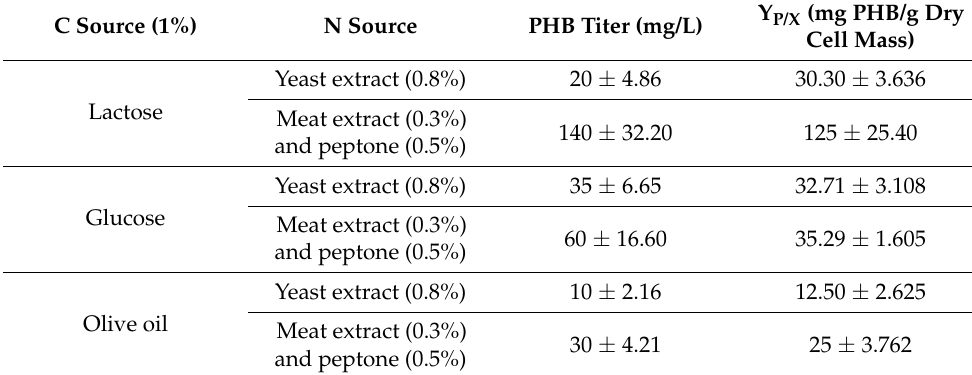
Table 1. Comparison of olive oil, glucose, and lactose by PHB titer (mg/L) and Y P/X (mg PHB/g dry cell mass). Y P/X (mg PHB/g Dry C Source (1%) N Source PHB Titer (mg/L) Cell Mass) Yeast extract (0.8%) 20 ± 4.86 30.30 ± 3.636 Lactose Meat extract (0.3%) 140 ± 32.20 125 ± 25.40 and peptone (0.5%) Yeast extract (0.8%) 35 ± 6.65 32.71 ± 3.108 Glucose Meat extract (0.3%) 60 ± 16.60 35.29 ± 1.605 and peptone (0.5%) Yeast extract (0.8%) 10 ± 2.16 12.50 ± 2.625 Olive oil Meat extract (0.3%) 30 ± 4.21 25 ± and peptone (0.5%)